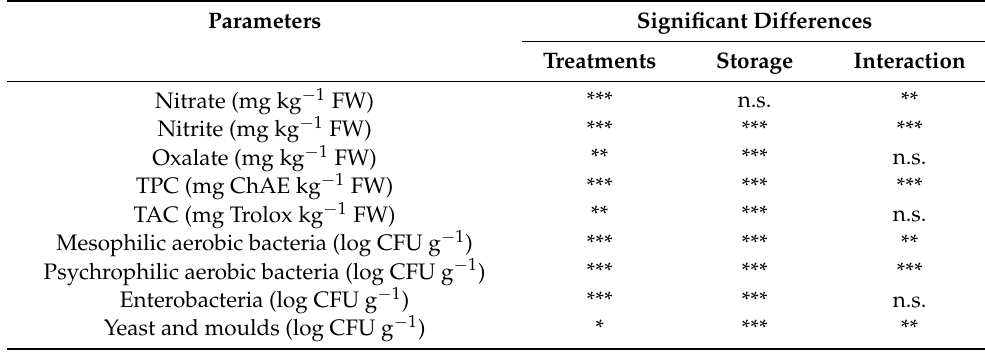
Table 3. Influence of fertilization and storage on the ion contents (nitrate, nitrite, oxalate), total pheno- lic content (TPC), total antioxidant capacity (TAC), and microbial load (mesophilic and psychrophilic aerobic bacteria, enterobacteria and yeast and moulds) in spinach leaves at